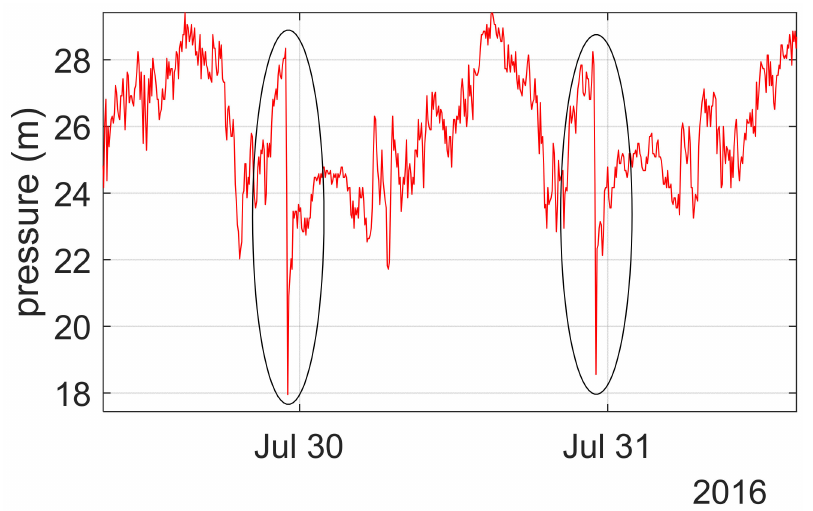
Figure 3. Trends in the pressure with a 5 min time step over two days highlighting the operation of pressure reduction through two